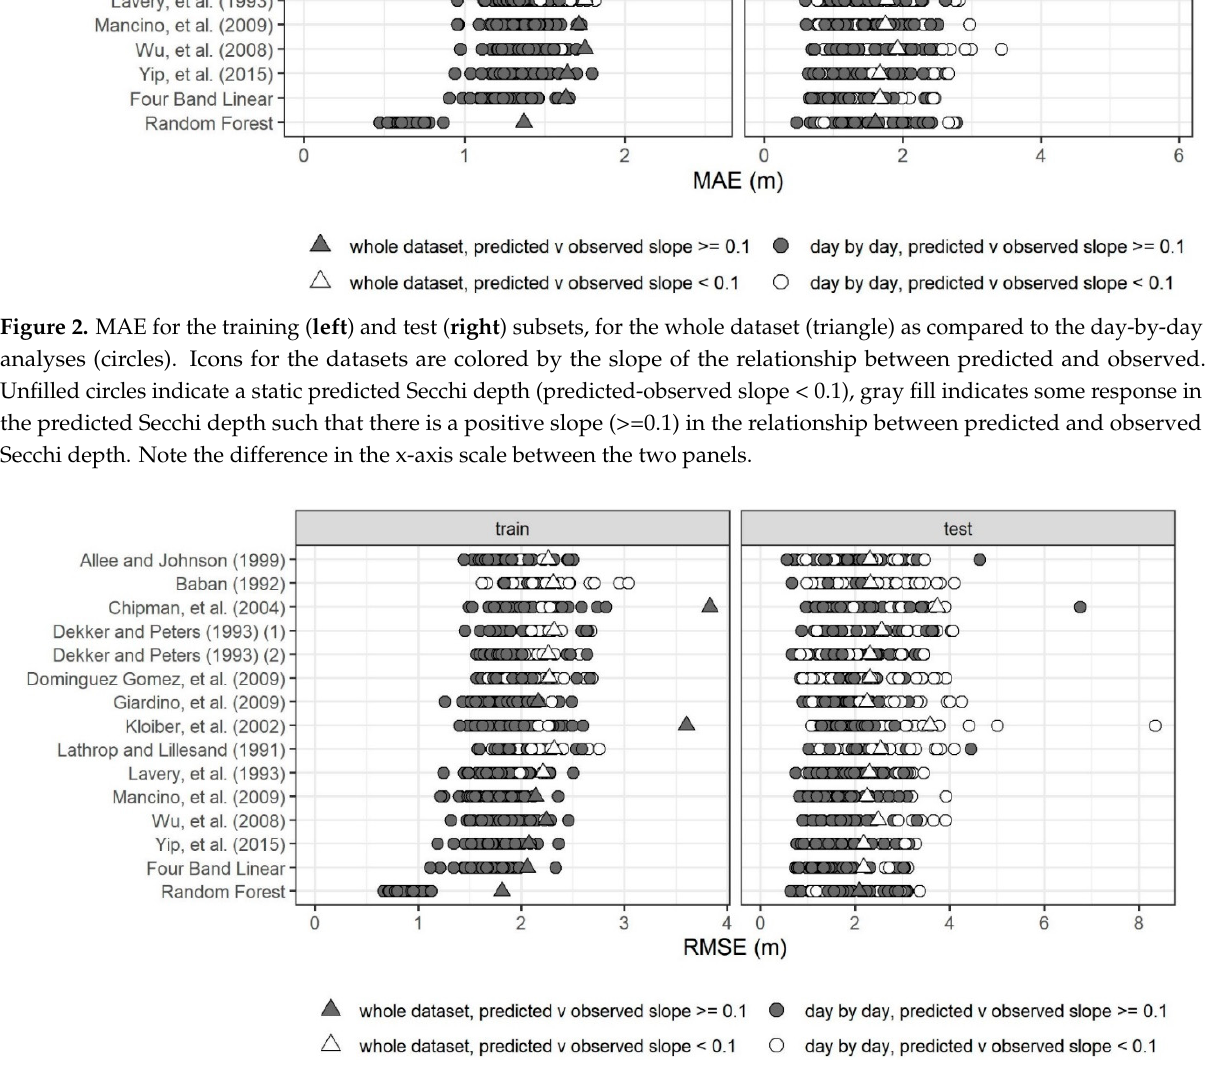
Figure 2. MAE for the training ( left ) and test ( right ) subsets, for the whole dataset (triangle) as compared to the day-by- day analyses (circles). Icons for the datasets are colored by the slope of the relationship between predicted and observed. Unfilled circles indicate a static predicted Secchi depth (predicted-observed slope < 0.1), gray fill indicates some response in the predicted Secchi depth such that there is a positive slope (>=0.1) in the relationship between predicted and observed Secchi depth. Note the difference in the x-axis scale between the two panels.